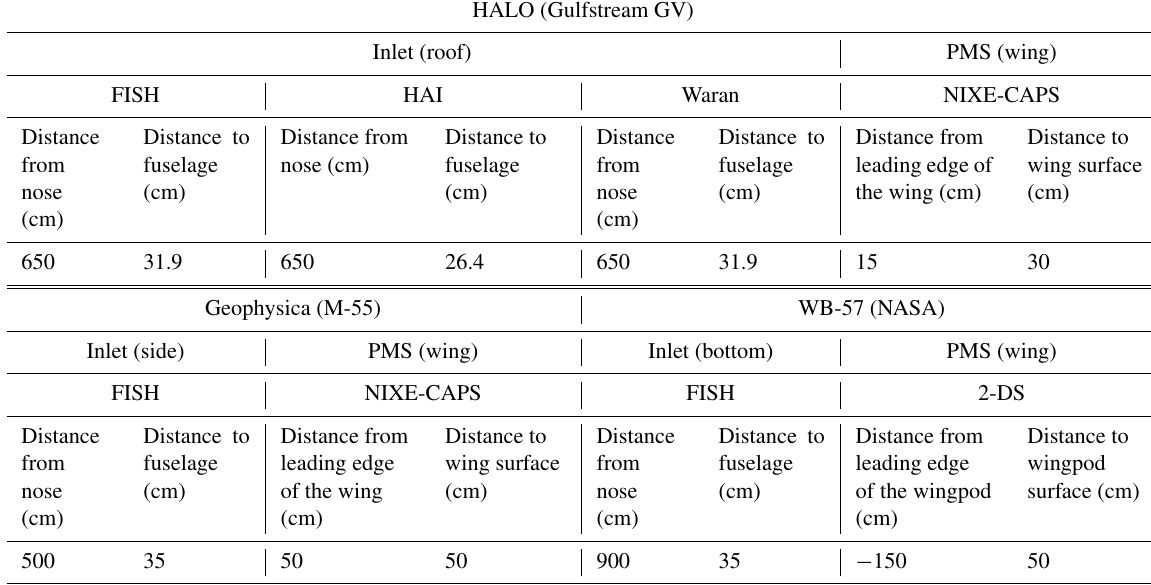
Table 1. Positions of the total water inlets and cloud spectrometers at the three aircraft (see Figs. 4–7). HALO (Gulfstream